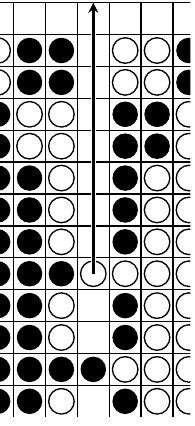
Figure 27. Obstacle’s WHITE leaves.